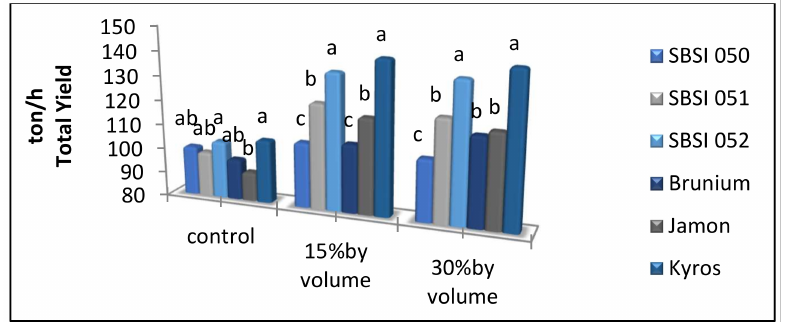
Figure 5. The interaction effects of methanol × genotype on total yield. Means followed by the same letter(s) is/are not significantly differ at 5% level of